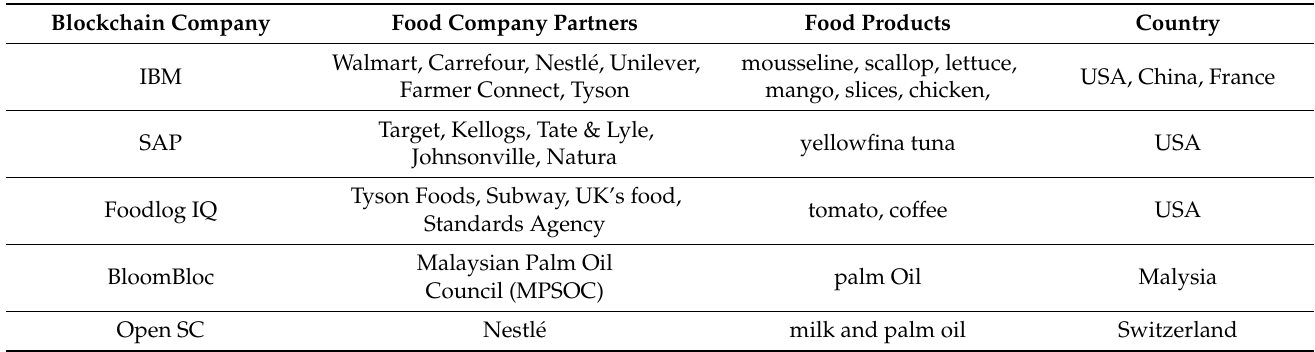
Table 1. Blockchain technology in the agri-food collaboration area.